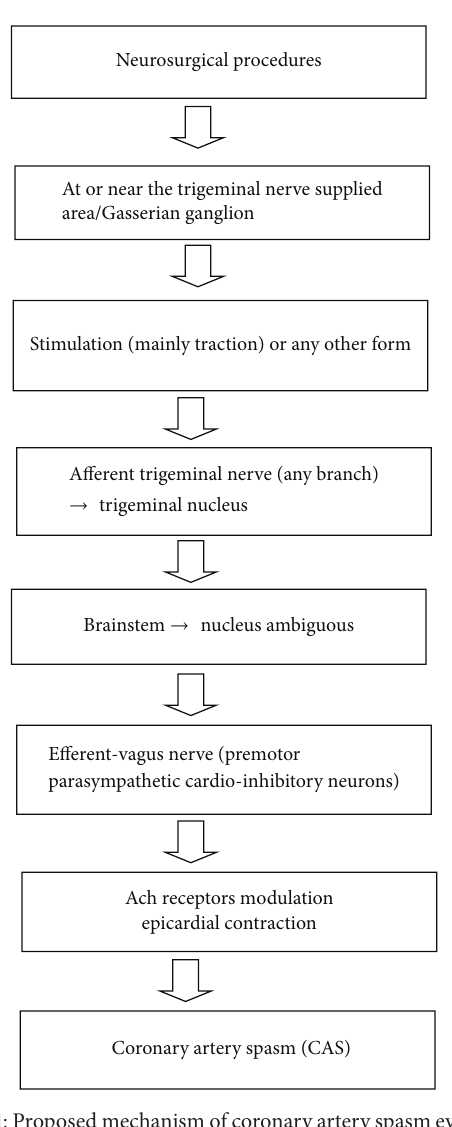
Figure 1: Proposed mechanism of coronary artery spasm evoked by TCR in neurosurgical